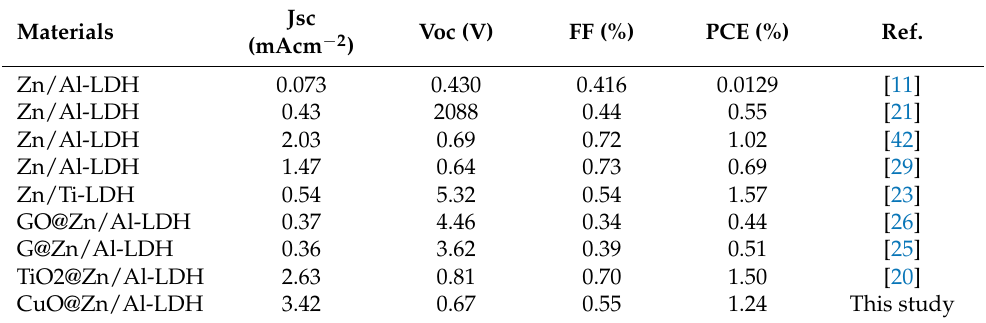
Table 2. Photovoltaic characteristics of the current work as compared to reported studies. Figure 7 elucidates the IPCE curves based on MMO-550 ◦ and CuO@MMO-T DSSC